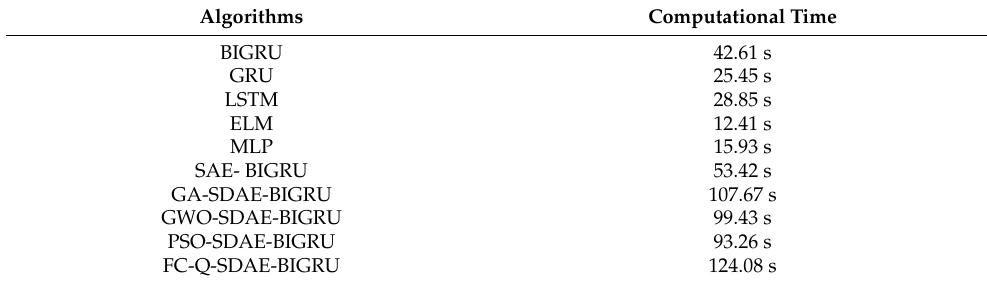
Table 4. The average computational time of different models in the axle temperature dataset.